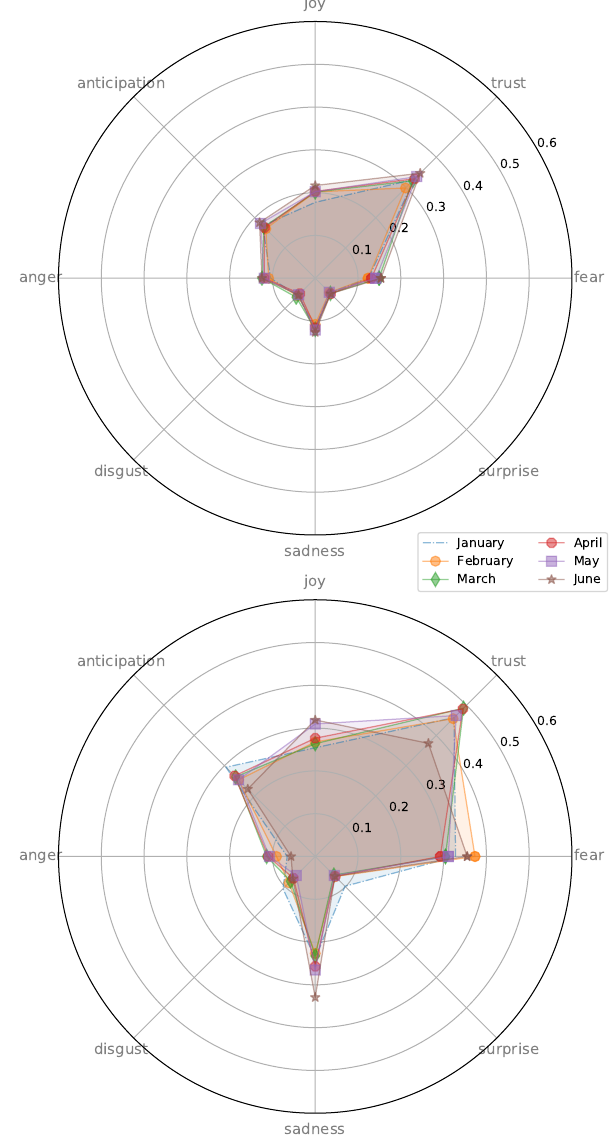
Figure 15. Radar plot of most expressed emotions in Italy per month for both 2019 ( top ) and 2020 ( bottom )